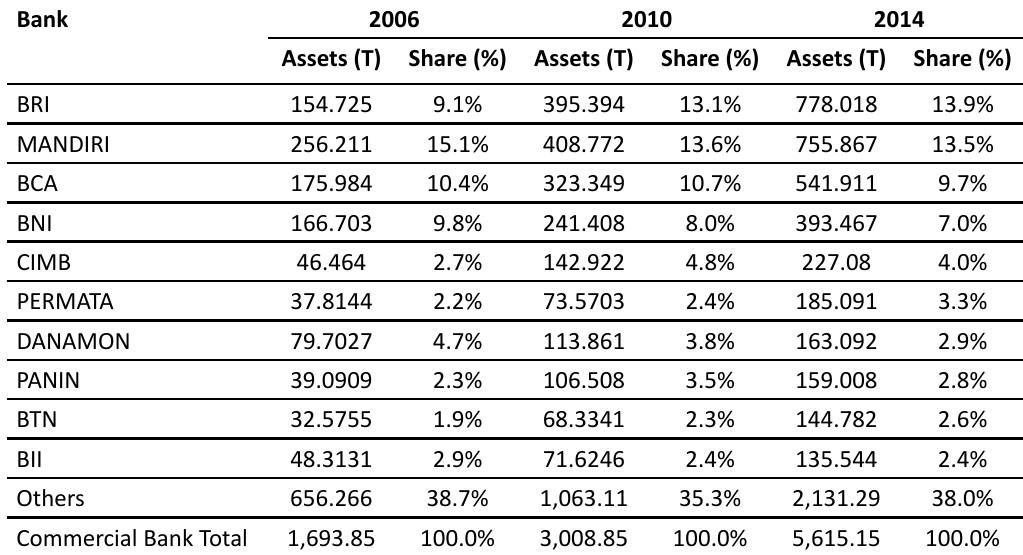
Table 3: Assets and Share of Assets of Top 10 Banks in 2006, 2010, and 2014